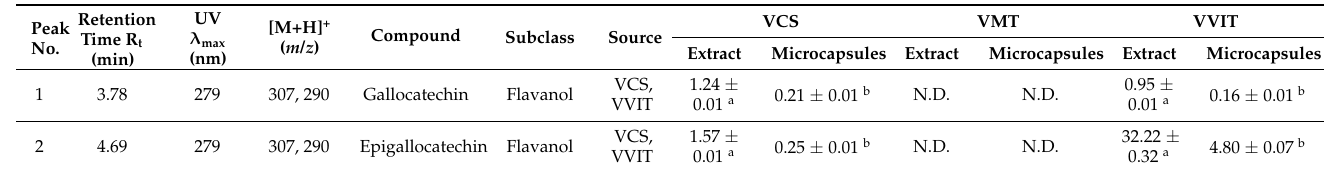
Table 2. Phenolic compounds identified in aqueous and microencapsulated extracts of VCS, VMT and VVIT leaves expressed as